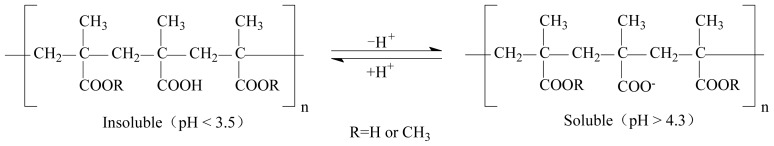
The chemical structure and reversible soluble mechanism of Eudragit L-100.